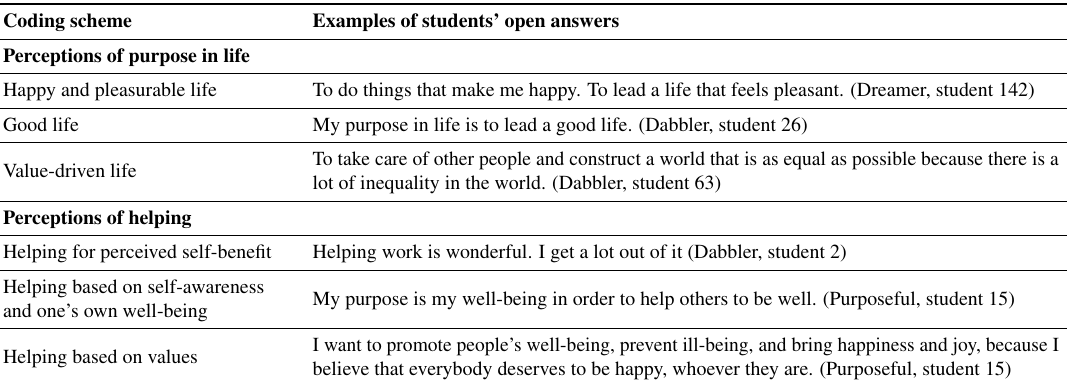
Table 2. Coding scheme and examples of open